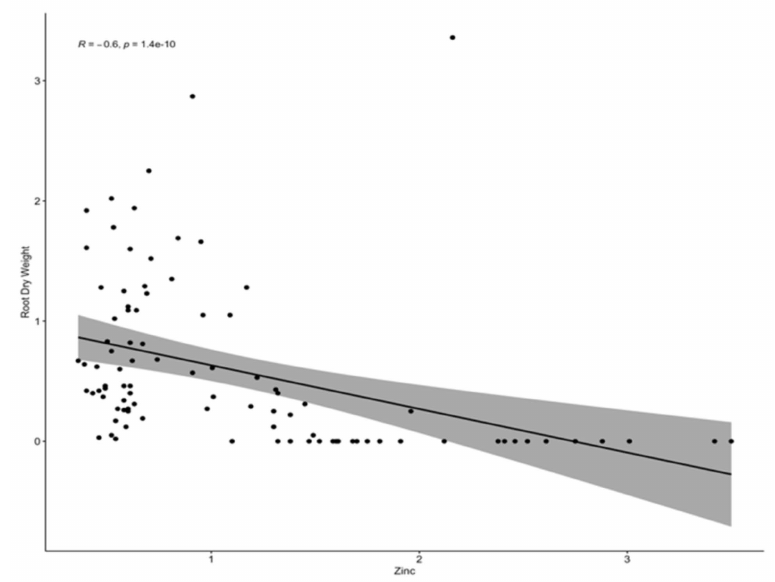
Figure 3. Root dry weight (R-DW) (g) × zinc (ppm), Spearman’s correlation for T. incarnatum .